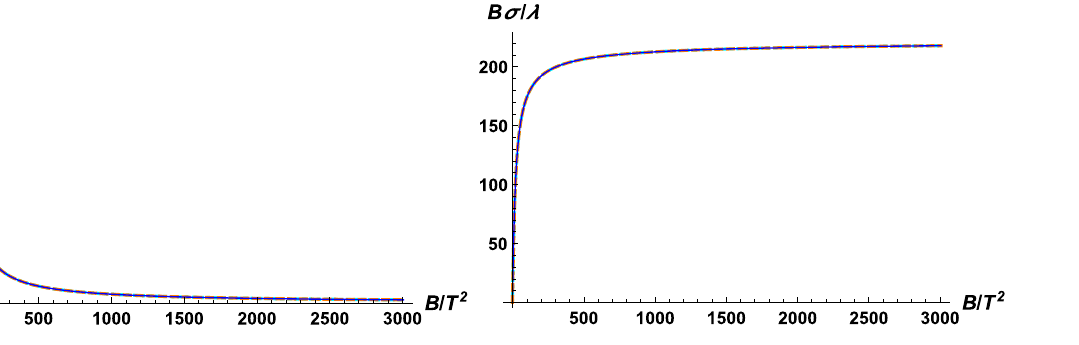
asafunctionof B / T 2 : α = 1 / 20 ,λ = 1 / 50fordashedcurveand α = 1 / 20 ,λ = 1 / 20 h